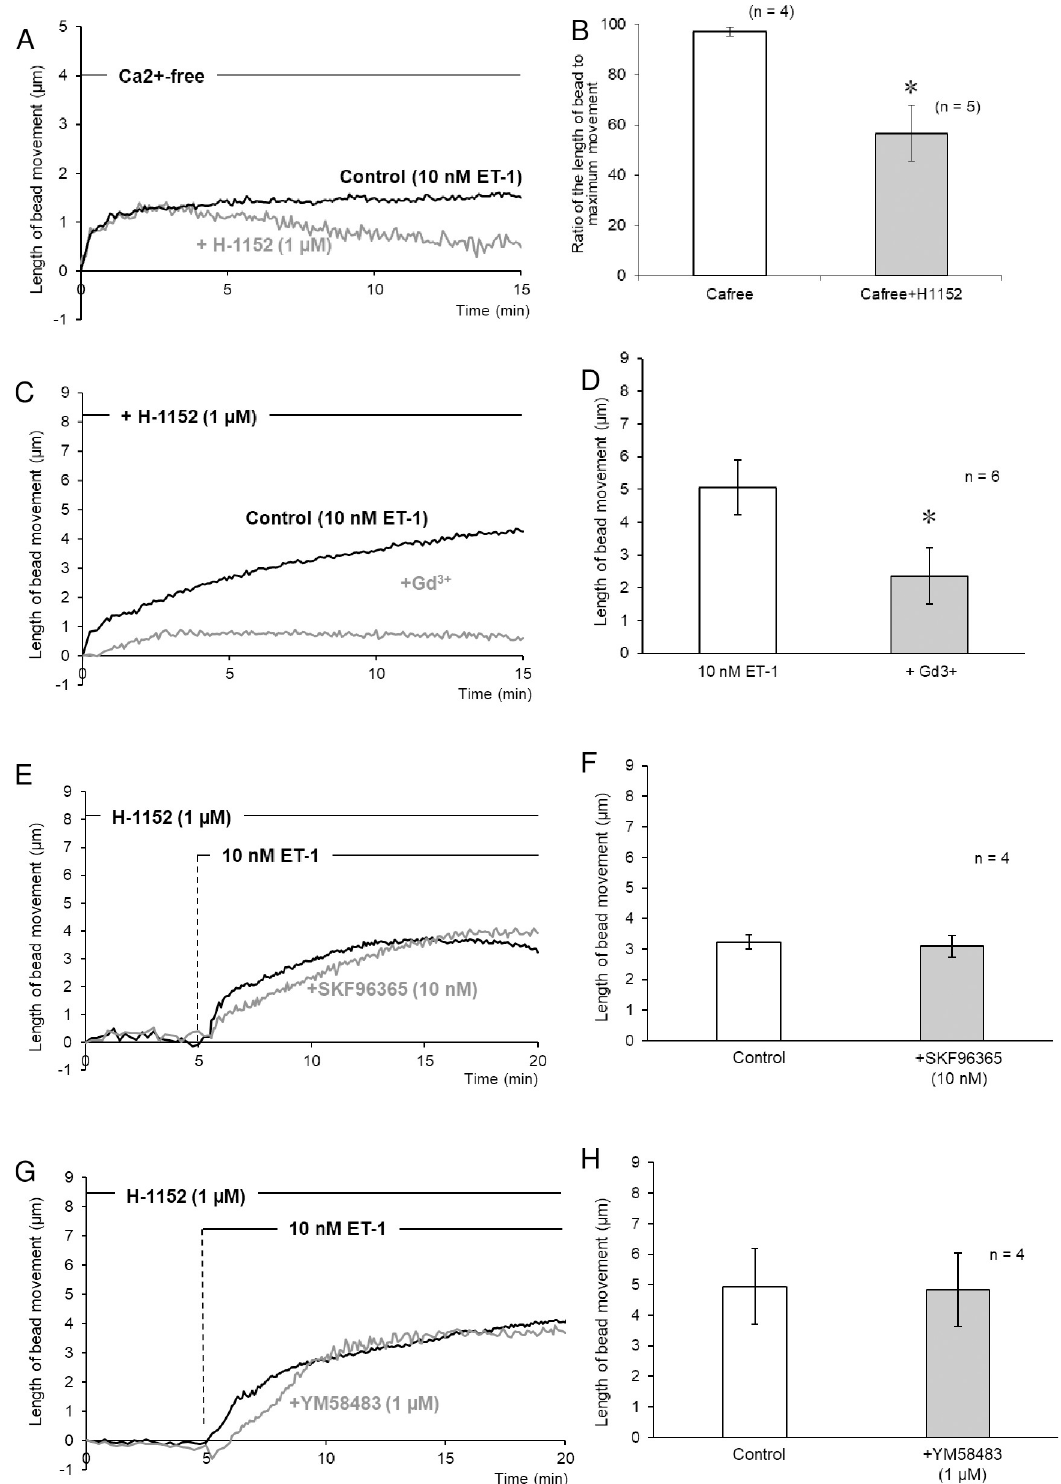
Fig 5. Ca 2+ influx-independent ET-1-induced contraction of isolated mouse non-activated HSCs. (A, B) Effect of the Rho- kinase inhibitor H-1152 on ET-1-induced contraction in Ca 2+ -free solution containing 1.5-mM EGTA. (A) Traces represent typical time-courses of changes in length of bead movement after treatment with ET-1 (10 nM) in the absence and presence of H-1152